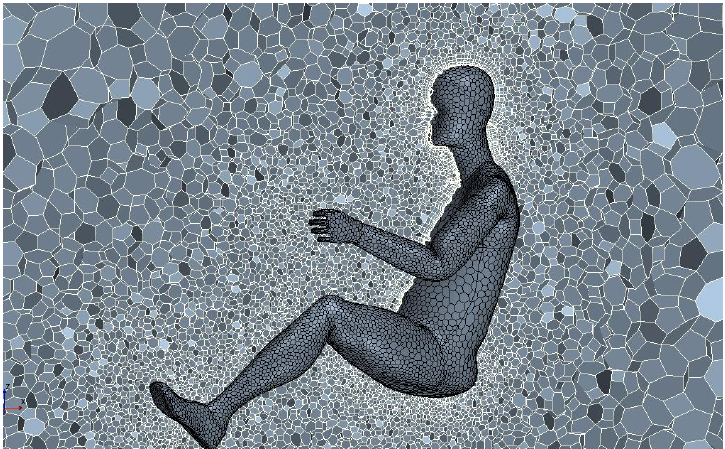
Figure 10. Manikin mesh refinement area.